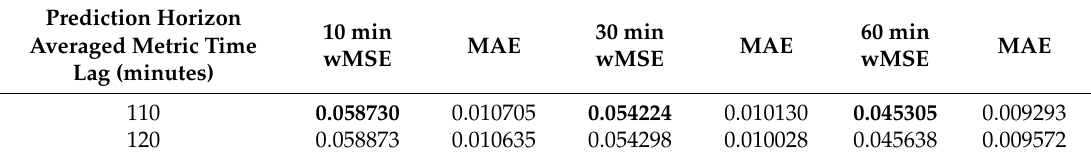
Table 3. Comparison of prediction metrics using time lags of 120 and 110 minutes. Minimum wMSE values marked in